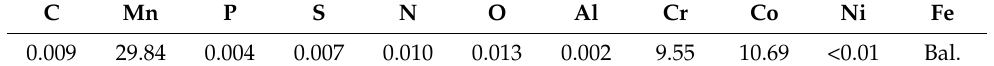
Table 1. Chemical composition of the HEA used (mass%).